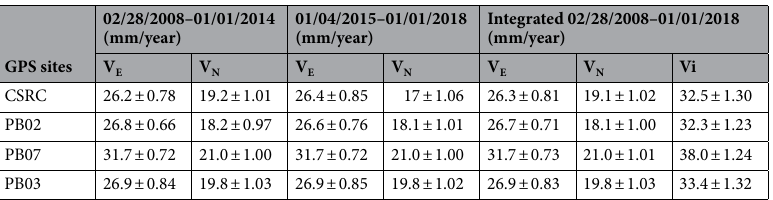
Table 1. Summary of the interseismic velocities of CRSC, PB02, PB07 and PB03, the last column is the integrated velocity from 2008 to 2018.